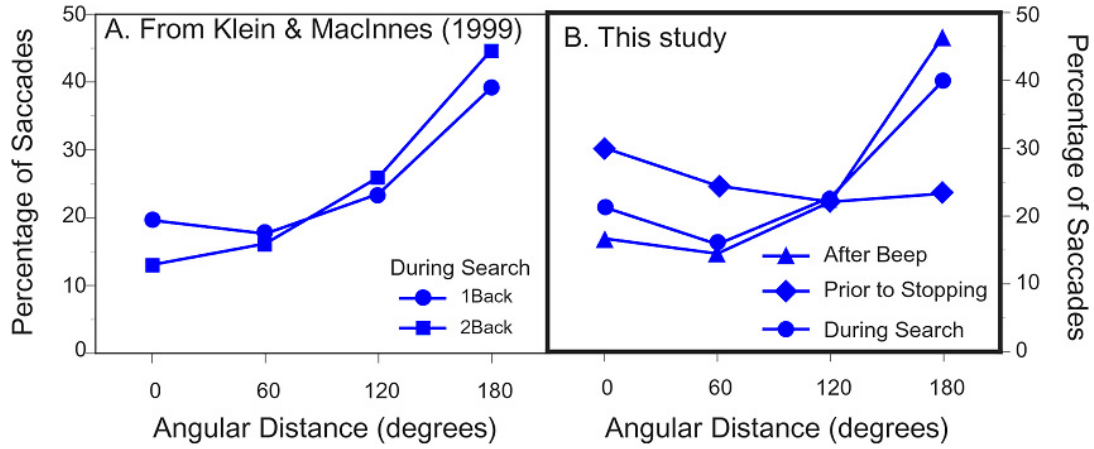
FIGURE 4 . Percentage of pre-probe saccades executed in various directions based on the angular distance from a previous fixation: (a) from Klein and MacInnes ([1], Experiments 1 and 2), (b) the current study. In the current study: ‘after beep’ refers to saccades immediately after a voluntary cessation of search (signaled by a 500 ms fixation duration) and signal to resume searching; ‘prior to stopping’ refers to the saccade immediately before such a cessation; and ‘search’ refers to all other pre-probe